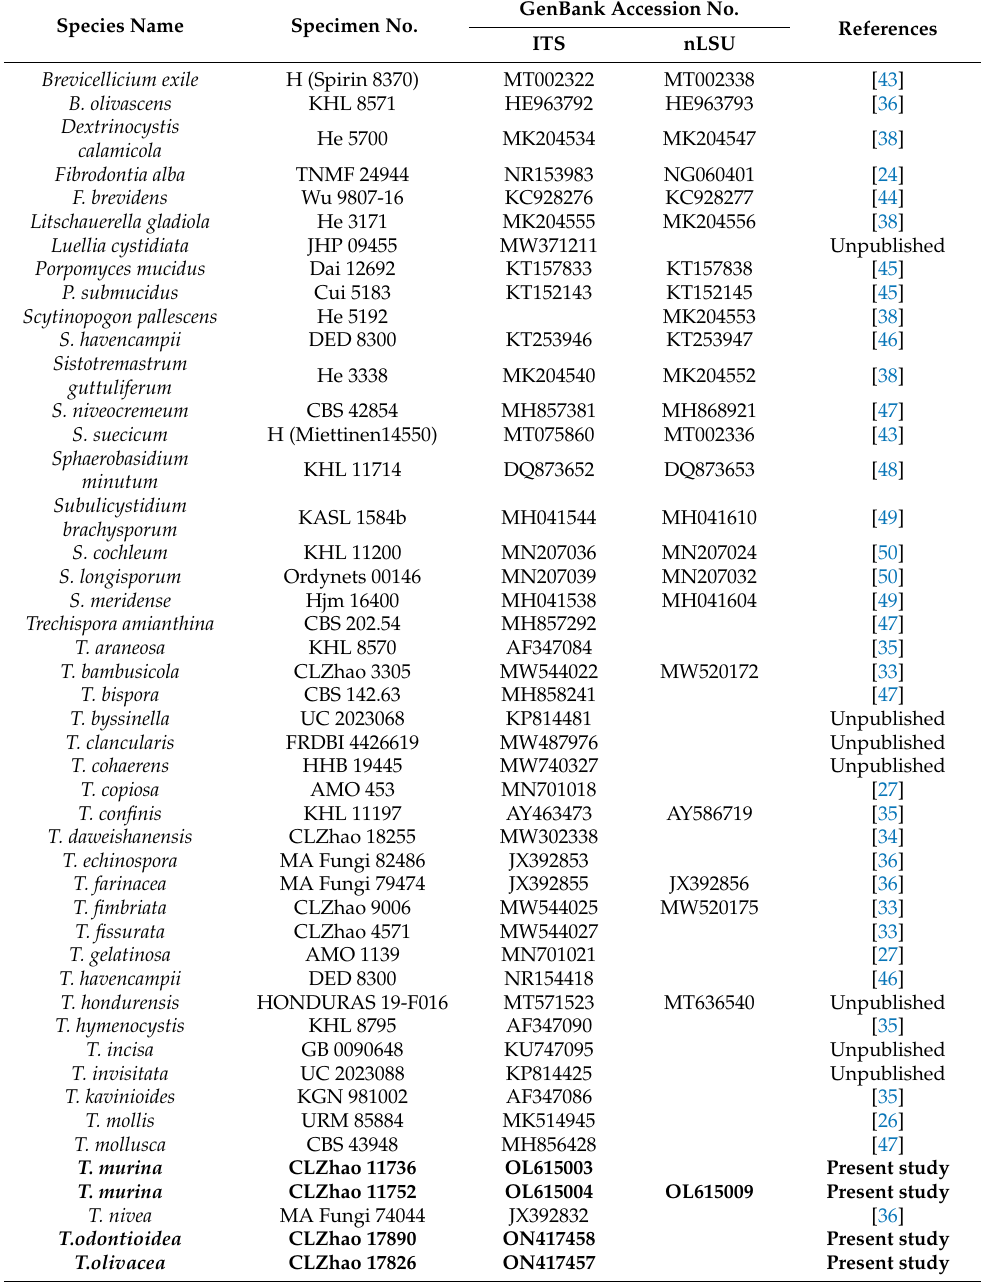
Table 1. List of species, specimens, and GenBank accession numbers of sequences used in this study, the newly generated sequences are in bold